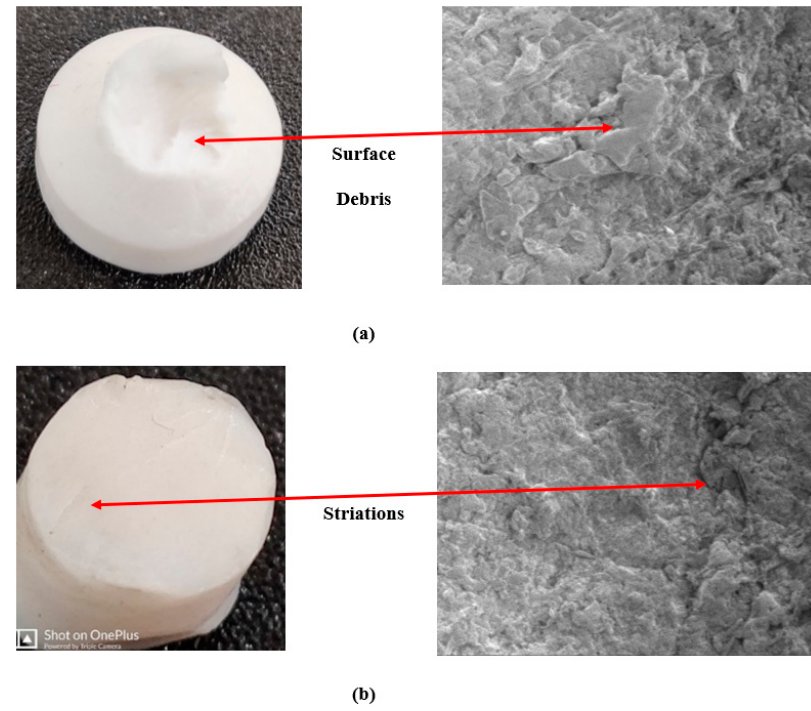
Figure 6. ( a ) Crescent shaped edge. ( b ) fractured surface for lower fretting depth.